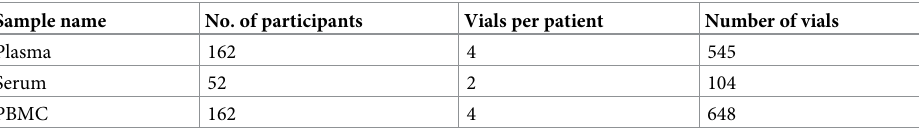
Table 2. Summary of samples processed and bio